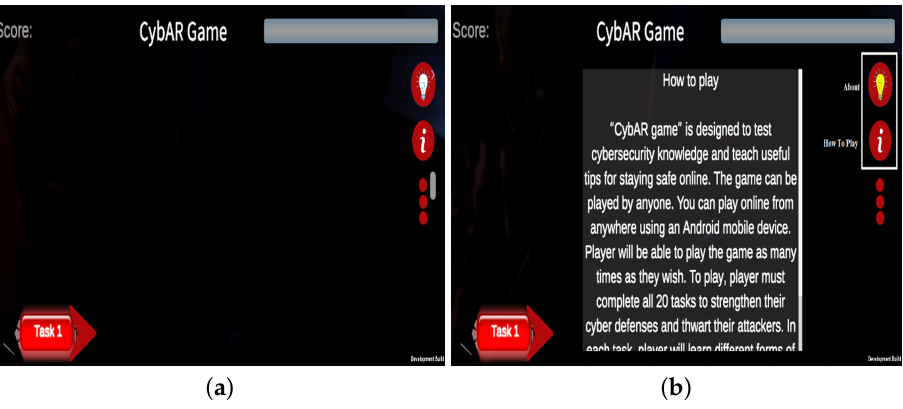
Figure 8. ( a ) CybAR Game UI. ( b ) CybAR Game About and How to play